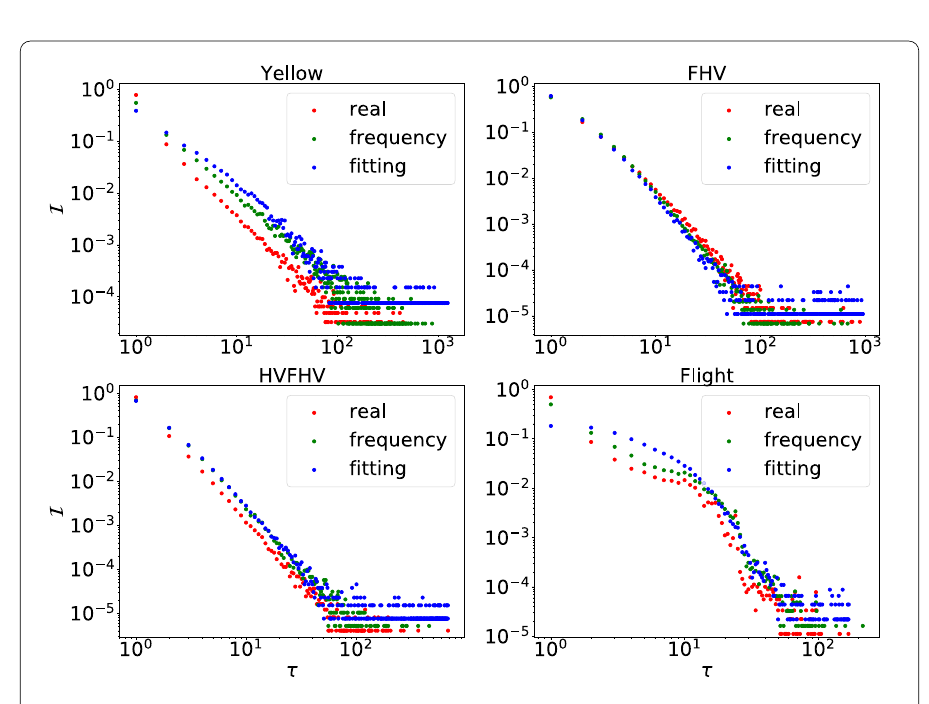
Figure 6 Closeness distribution of simulation result